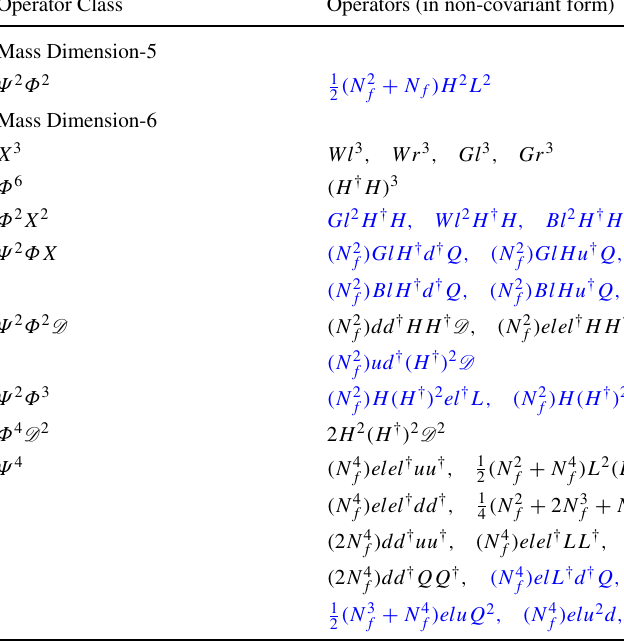
Table 23 SM: operators of mass dimensions-5 and -6 Operator